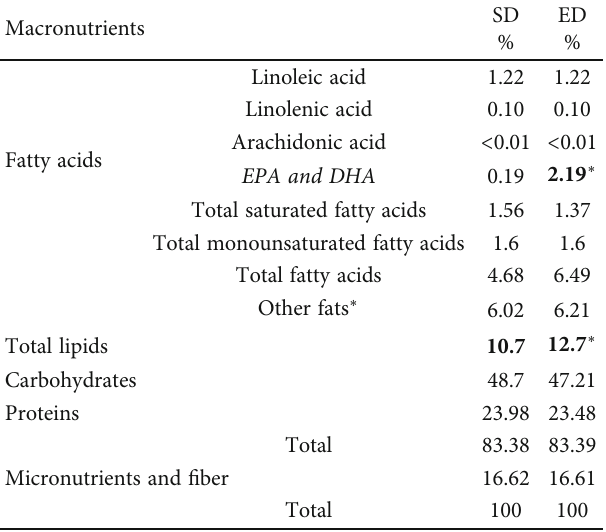
Table 1: Nutritional content of the standard diet, compared to the enriched diet.